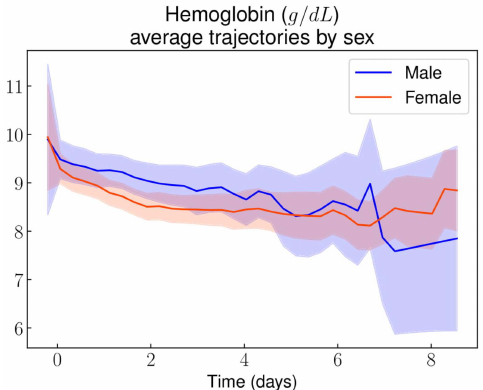
Figure A4. Hemoglobin average trajectory throughout non-complicated VOC-related hospital stays, stratified by sex.